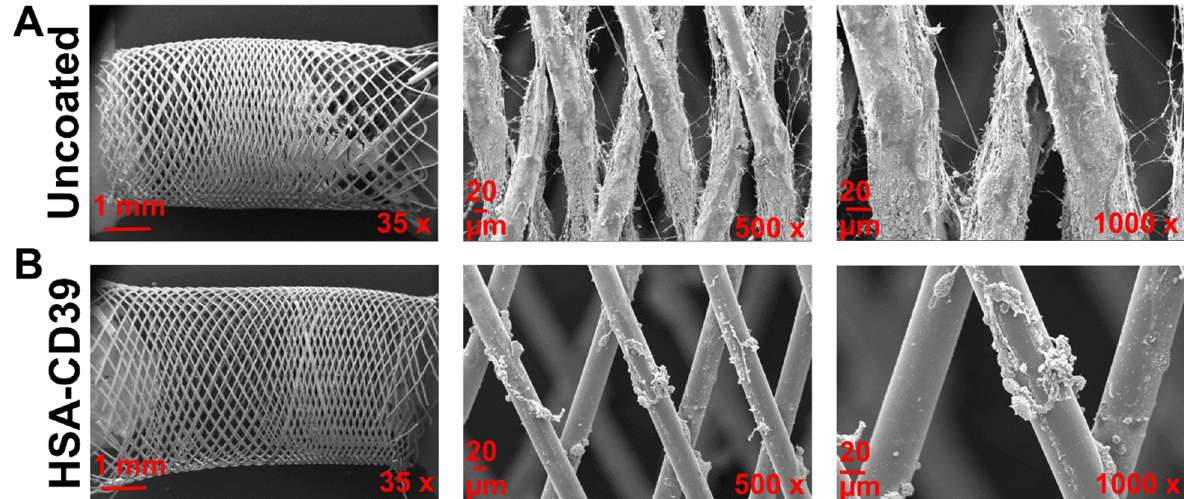
Figure 8. HSA–CD39 coated onto nitinol BlueOxide stents reduces blood cell adhesion during incubation in a dynamic in vitro model. SEM analysis of coated nitinol BlueOxide stents after circulation with human whole blood for 60 min at 150 mL/min (thrombogenicity model). Uncoated: bare nitinol BlueOxide stent. Different magnifications (35×, 500× and 1000×) show the amount of blood cell adhesion.